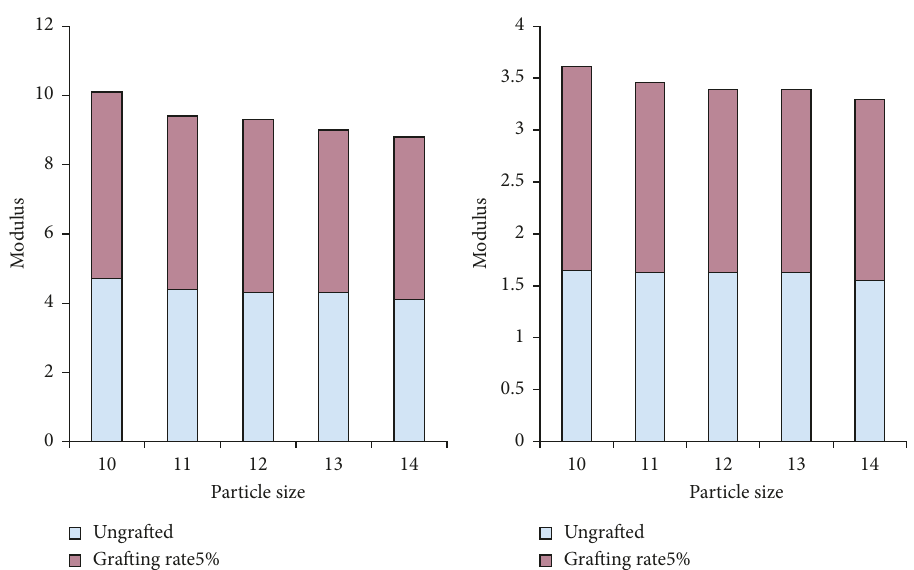
Figure 8: Schematic diagram of the relationship between composite shear modulus and particle size.